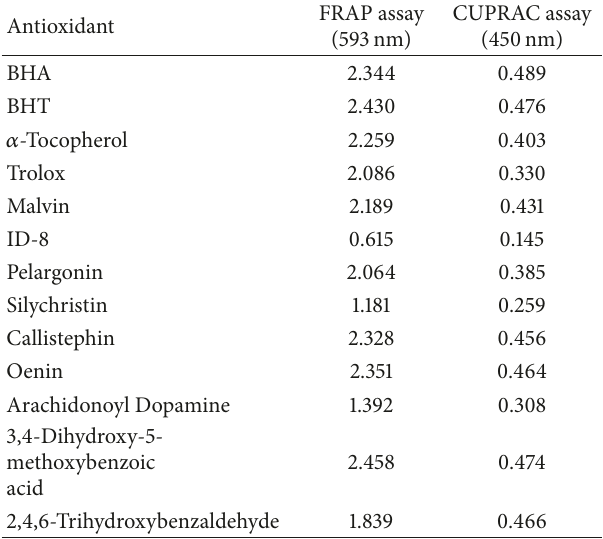
Table 3: Fe 3+ and Cu 2+ reducing activities of reference antioxidants and selected phenolic and flavonoid compounds at 30 𝜇 g/mL con-